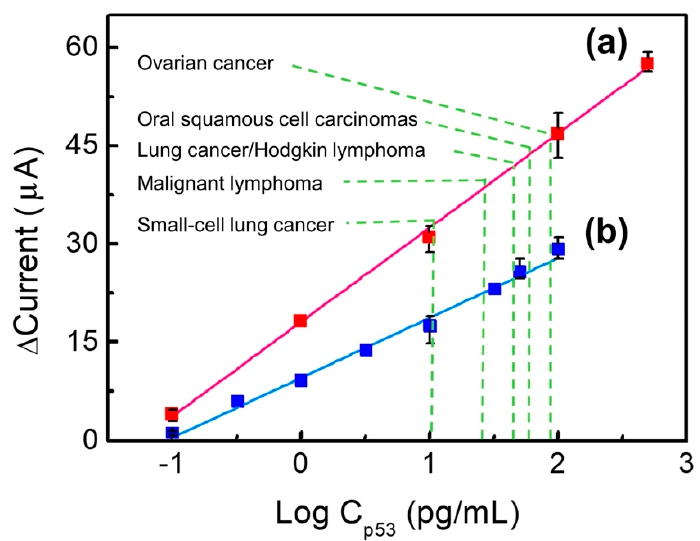
Figure 6. A comparison of the concentration of p53 antigens detected with Au/NiPc/anti-p53/BSA electrodes. The anti-p53 concentrations of the red line is 100 ng/mL ( a ) and for the blue line is 1 ng/mL ( b